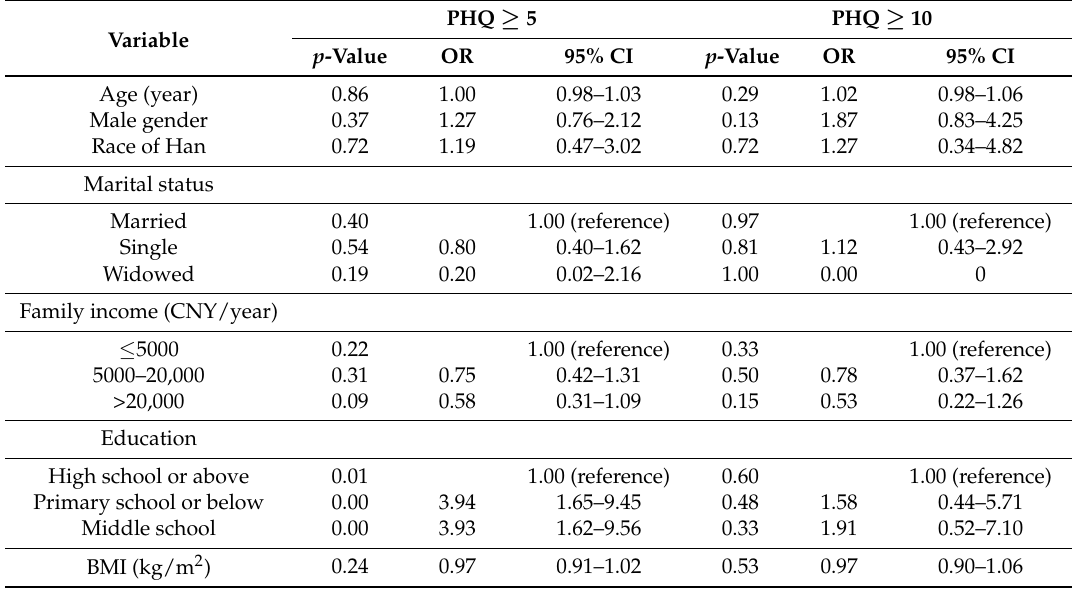
Table 3. Multivariable logistic regression analyses for depression among diagnosed diabetes